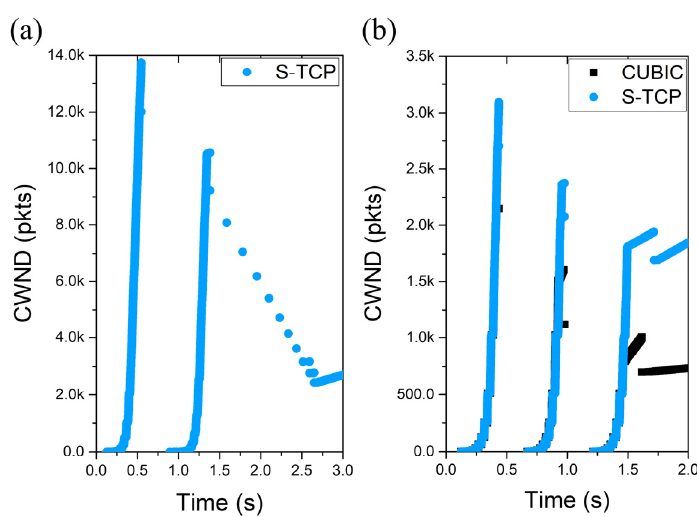
Figure 4. Cwnd change during the slowstart phase: ( a ) single S-TCP; ( b ) CUBIC vs. S-TCP.